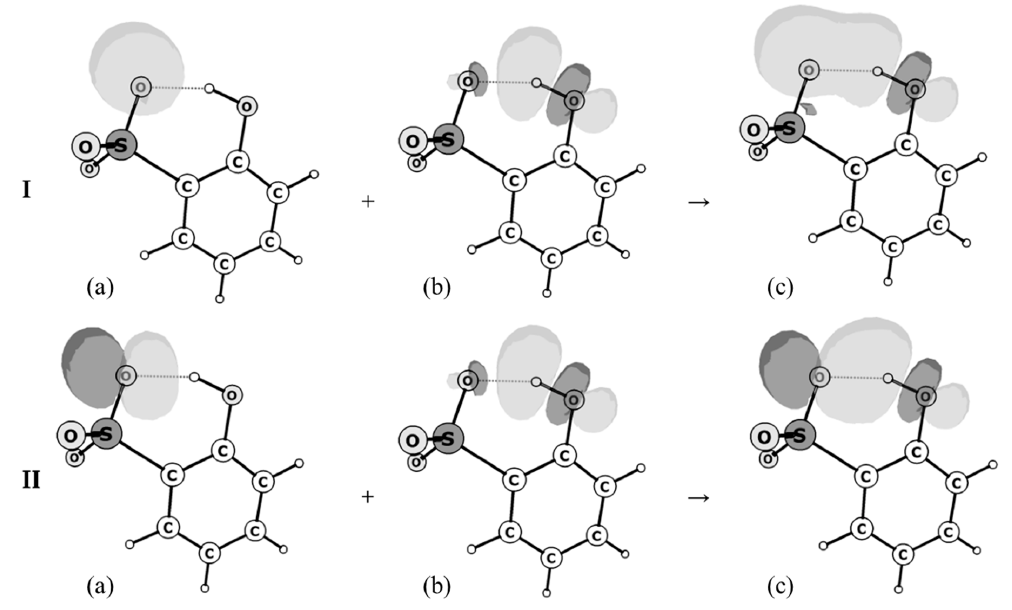
Figure 13. Deprotonated form of 2-OH-BSA. The natural bond orbitals and the donor-acceptor stabilization energy E (2) : I ( a ) donor LP1(O), ( b ) acceptor σ *(O-H), ( c ) LP1(O) → σ *(O-H), E (2) = 29.7 kJ mol − 1 ; II ( a ) donor LP2(O), ( b ) acceptor σ *(O-H), ( c ) LP2(O) → σ *(O-H), E (2) = 118.5 kJ mol − 1